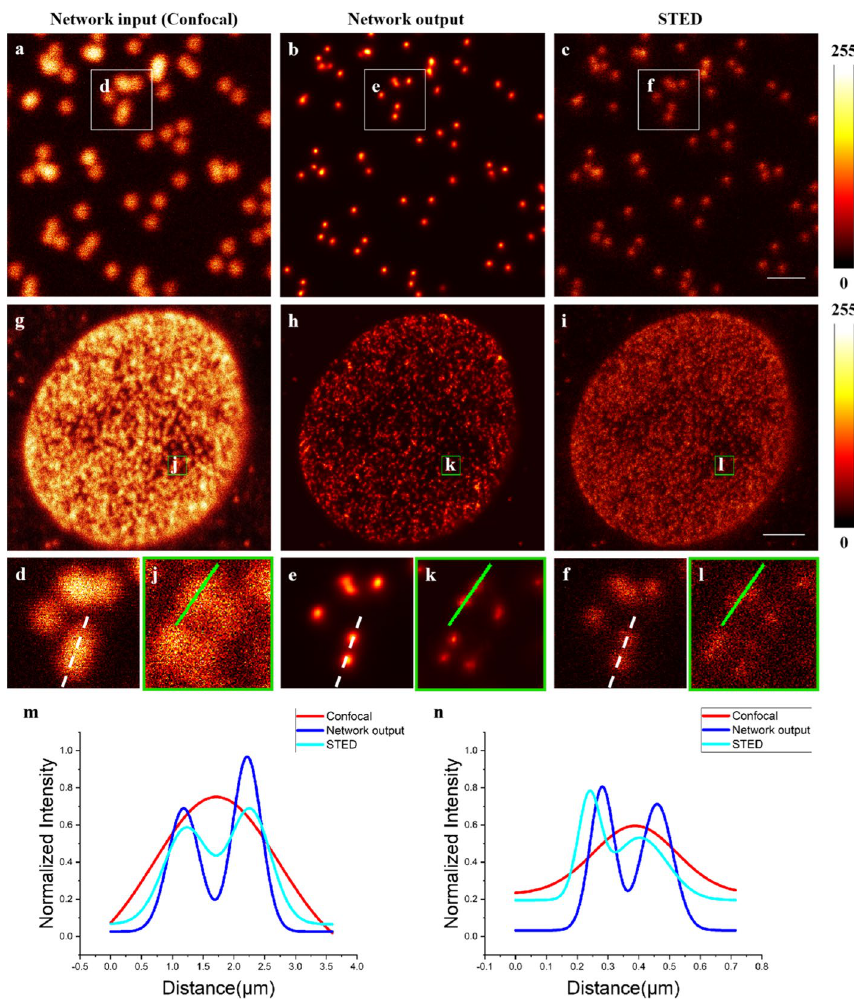
Fig. 3 Super-resolution imaging of the nano-beads and nucleus using TCAN. ( a ) A diffraction-limited confocal microscopy image of fluorescent nano-beads is used as input to the network. ( b ) The super-resolved output image. ( c ) The STED image of the same field of view. ( d , j ) Examples of closely spaced nano-beads or NPCs that cannot be resolved by confocal microscopy. ( e , k ) The trained network takes ( d ) and ( j ) as input and resolves the individual nano-beads or NPCs. ( f , l ) The STED microscopy image. ( g ) A diffraction-limited confocal microscopy image of HeLa cell nucleus is used as input to the network. ( h ) The super-resolved output image. ( i ) The STED image of the same field of view. ( m , n ) Intensity profiles along the white dashed lines and green solidlines in different images. Experiments are repeated with 20 images, achieving